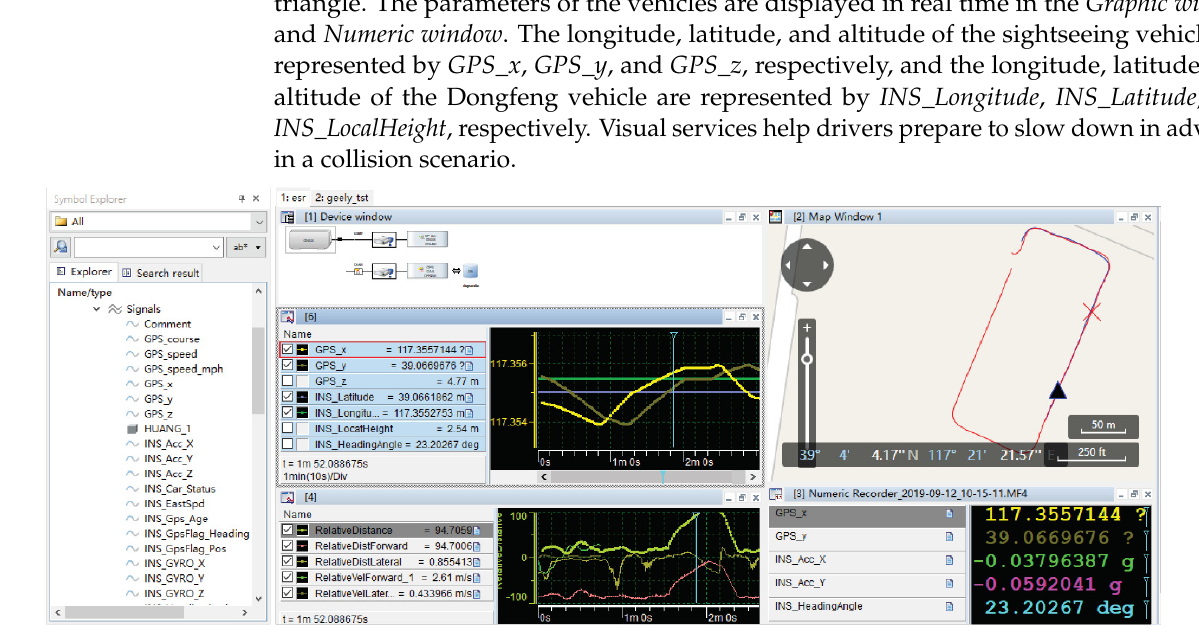
Figure 21. Relative_Dist_Forward of two vehicles.